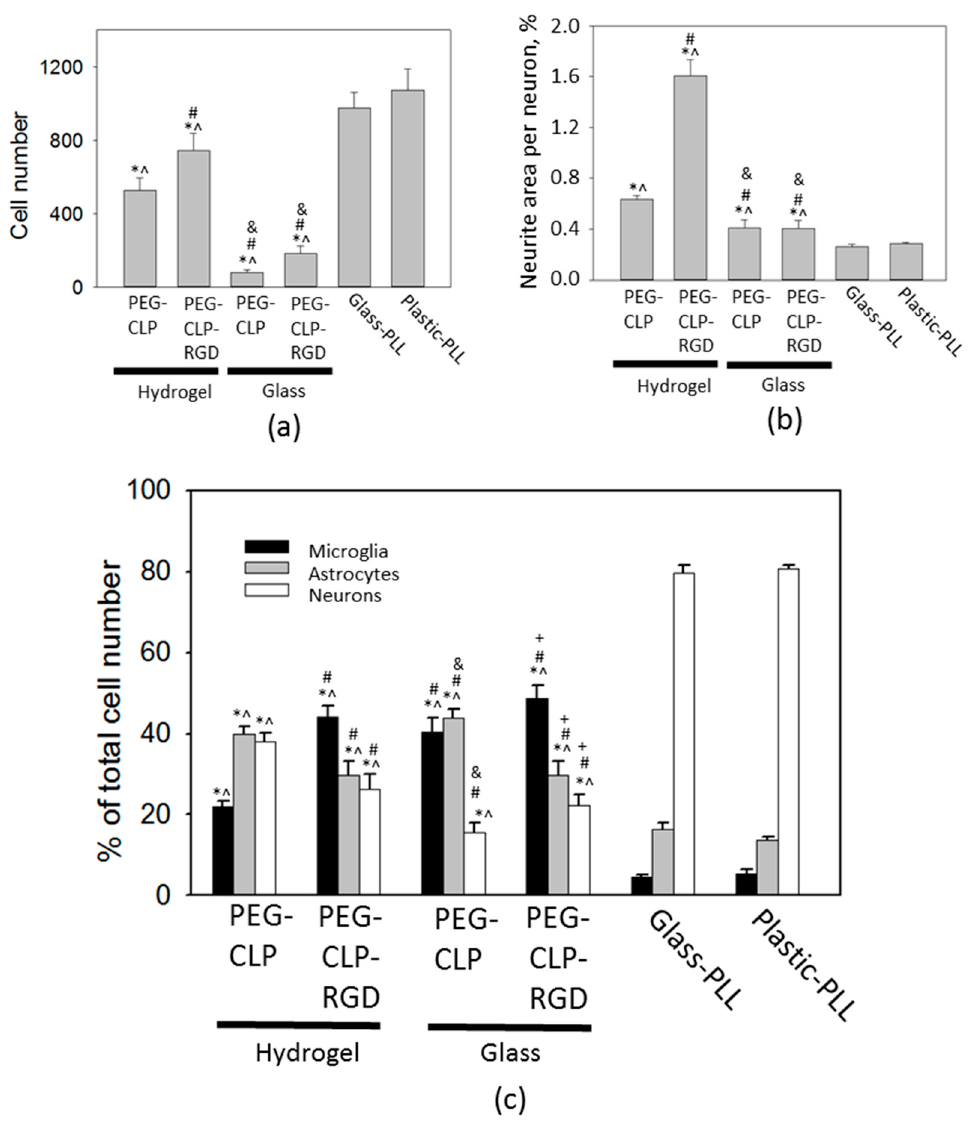
Figure 5. Quantitative comparison of the total cell number ( a ), neuritogenesis ( b ), and cellular composition ( c ) in cerebellar cell cultures on PEG-CLP and PEG-CLP-RGD hydrogels (membranes), on PEG-CLP- and PEG-CLP-RGD-coated glass, and on poly-L-lysine (PLL)-coated tissue culture glass and plastic substrates. Cell number in ( a ) was evaluated according to the number of Hoechst33342-positive nuclei in the 400 × 500 µm 2 area of the confocal micrographs. The amount of each cell type in ( b ) is represented as the percentage of the total cell number in the cultures. For neurite evaluation, the anti-MAP2-positive area in micrographs was calculated by the ImageJ software and represented as the percentage of the total image area per neuronal nucleus. The data are shown as averages of 3–6 experiments with standard error. *—statistically significant difference compared to Glass-PLL; ^— statistically significant difference compared to Plastic-PLL; #—statistically significant difference compared to PEG-CLP hydrogel; &—statistically significant difference compared to PEG-CLP-RGD hydrogel; and +—statistically significant difference compared to CLP glass; p ≤ 0.01.